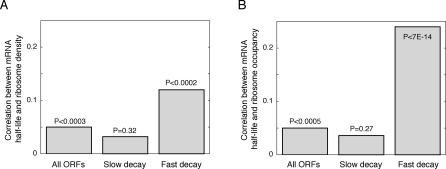
Correlations between Decay and Translation RatesPearson correlations together with corresponding p-values are shown for mRNA half-life versus (A) ribosome density and (B) ribosome occupancy. ORFs were, depending on mRNA half-life, grouped into all ORFs, 1,058 slowly decaying ORFs with t
1/2 ≥ 33 min, and 1,013 fast decaying ORFs with t
1/2 ≤ 13 min.